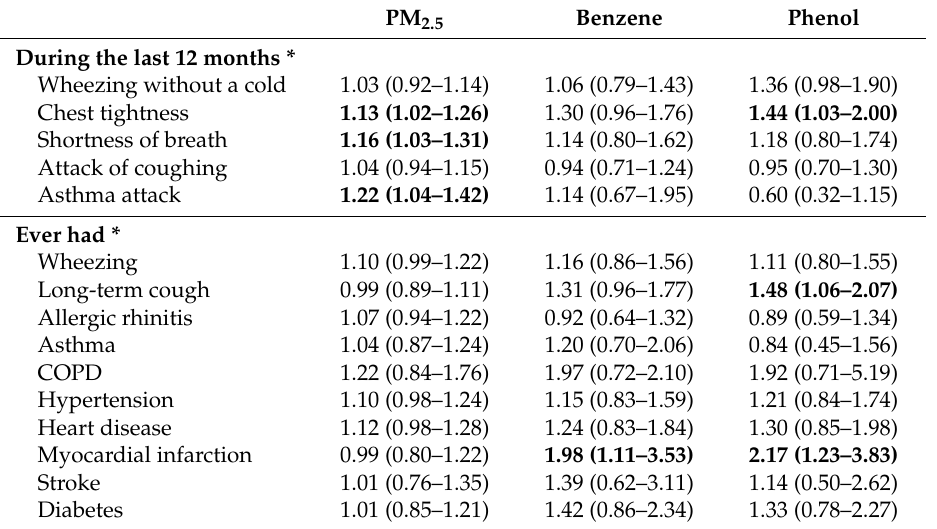
Table 3. Odds ratios (95% CI) on disease prevalence per interquartile change in pollutants concentrations. PM 2.5 Benzene